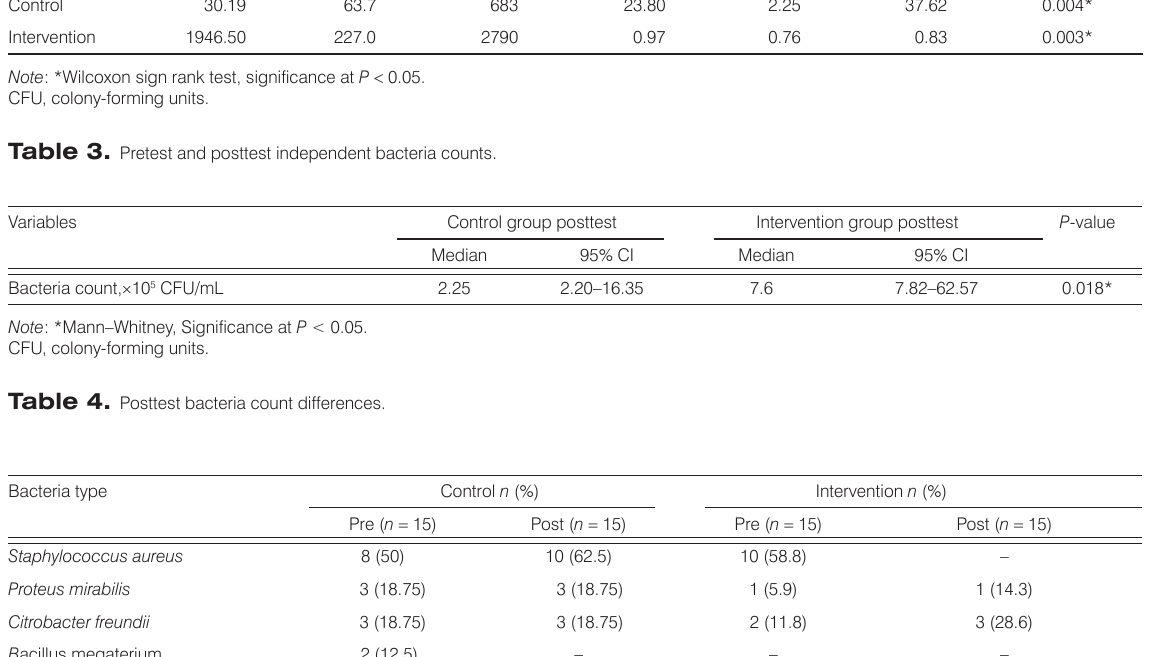
Table 5. Type of bacteria present in pretest and posttest